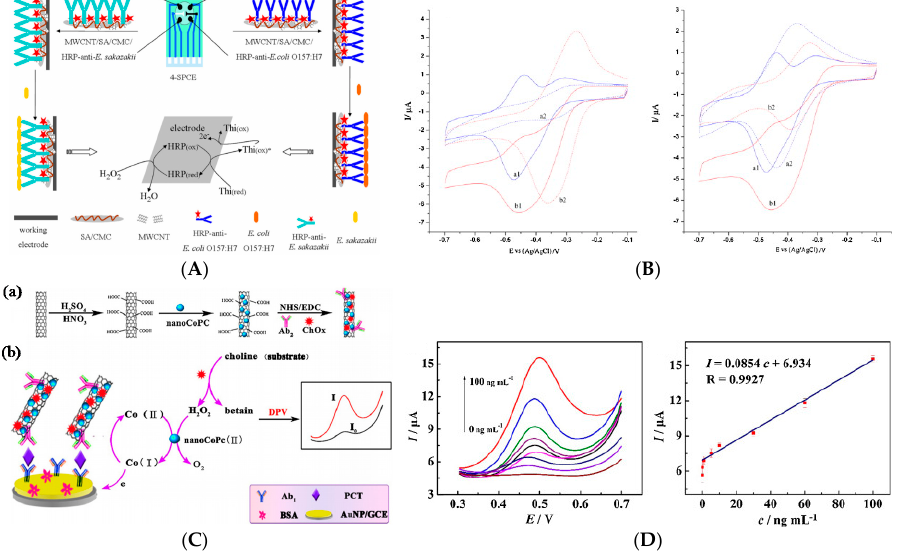
Figure 5. ( A ) Preparation of the immunoelectrode, and reactions occurring at the electrode surface for determination of E. sakazakii and E. coli O157:H7. Thi(ox) and Thi(red) are the oxidized and reduced forms of thionine, respectively; ( B ) CVs after incubation with E. sakazakii (10 10 cfu mL − 1 ) (left) and